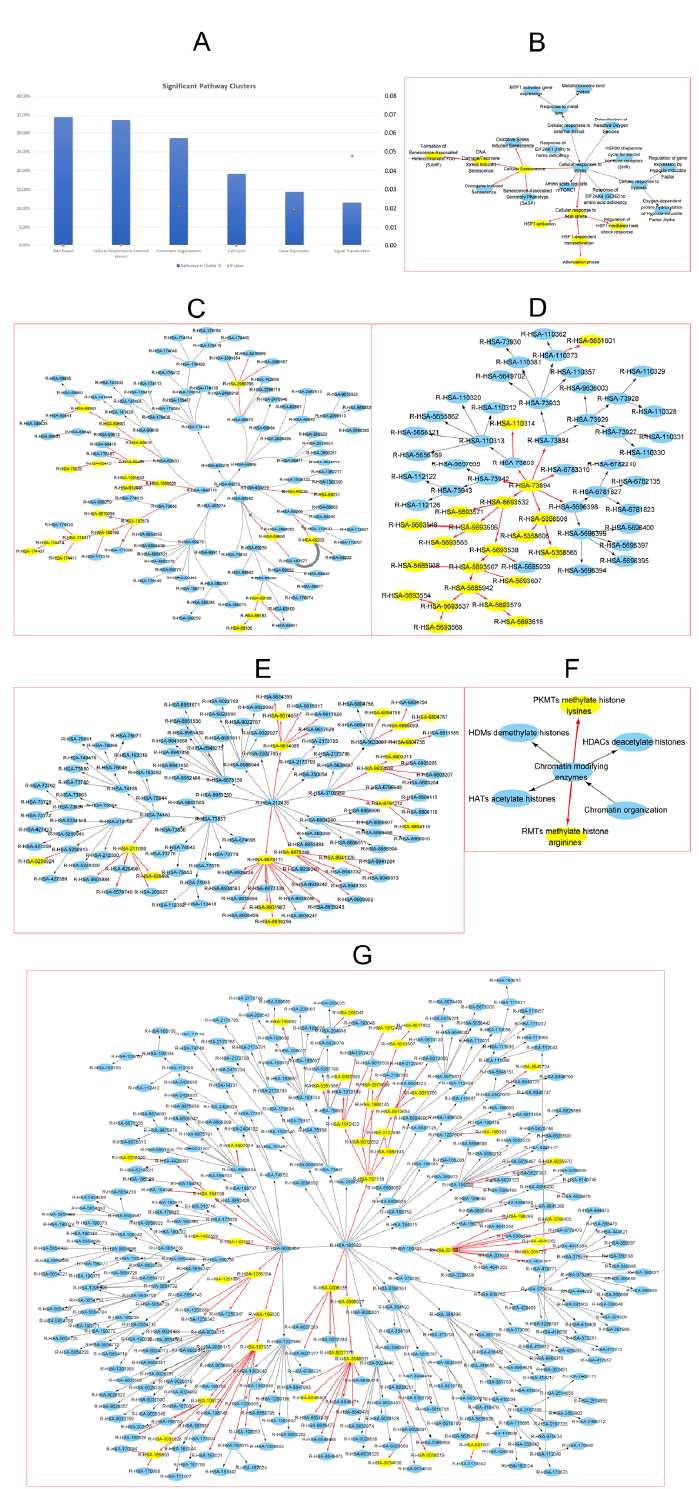
Figure 7. USP15 may repress HCC via six pathway clusters. USP15-HCC pathways are significantly enriched in six cancer-related clusters of the complete network of human pathway hierarchies. ( A ) Degree of enrichment (as a percentage) of the six cancer-related clusters. ( B ) Cluster “Cellular responses to external stimuli”. ( C ) Cluster “Cell Cycle”. ( D ) Cluster “DNA repair”. ( E ) Cluster “Gene expression”. ( F ) Cluster “Chromatin organization”. ( G ) Cluster “Signal transduction”. UP15-HCC pathways are highlighted in